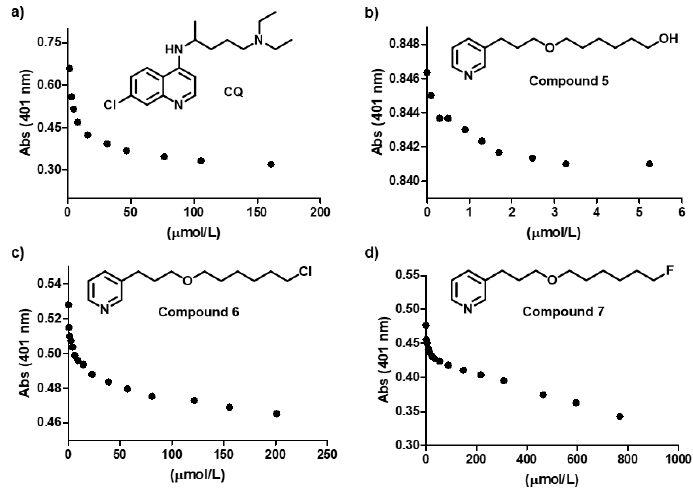
Figure 1. Titration of Hematin (5.0 µmol/L) With Increasing Concentrations of a) CQ (0-161.0 µmol/L) (inset shows a plot of absorbance at 401 nm versus the concentration of CQ); b) compound 5 (0-5.24 µmol/L) (inset shows a plot of absorbance at 401 nm versus the concentration of compound 5); c) compound 6 (0-201.0 µmol/L) (inset shows a plot of absorbance at 401 nm versus the concentration of compound 6); and d) compound 7 (0-767.0 µmol/L) (inset shows a plot of absorbance at 401 nm versus the concentration of compound